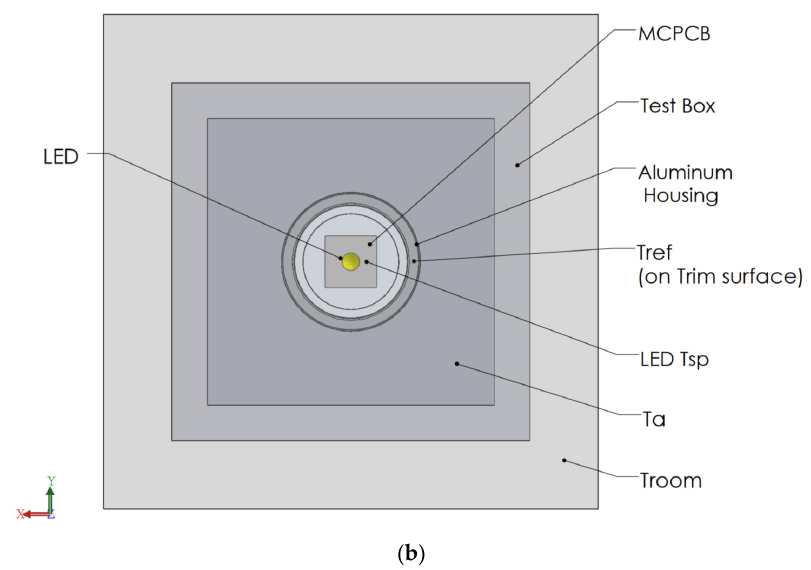
Figure 3. Illustration of the ( a ) isometric view of the ALFHS or CUFHS mounted to the CLRDL after INST; and ( b ) bottom view of LED, MCPCB, trim and the test point of T sp , T ref .